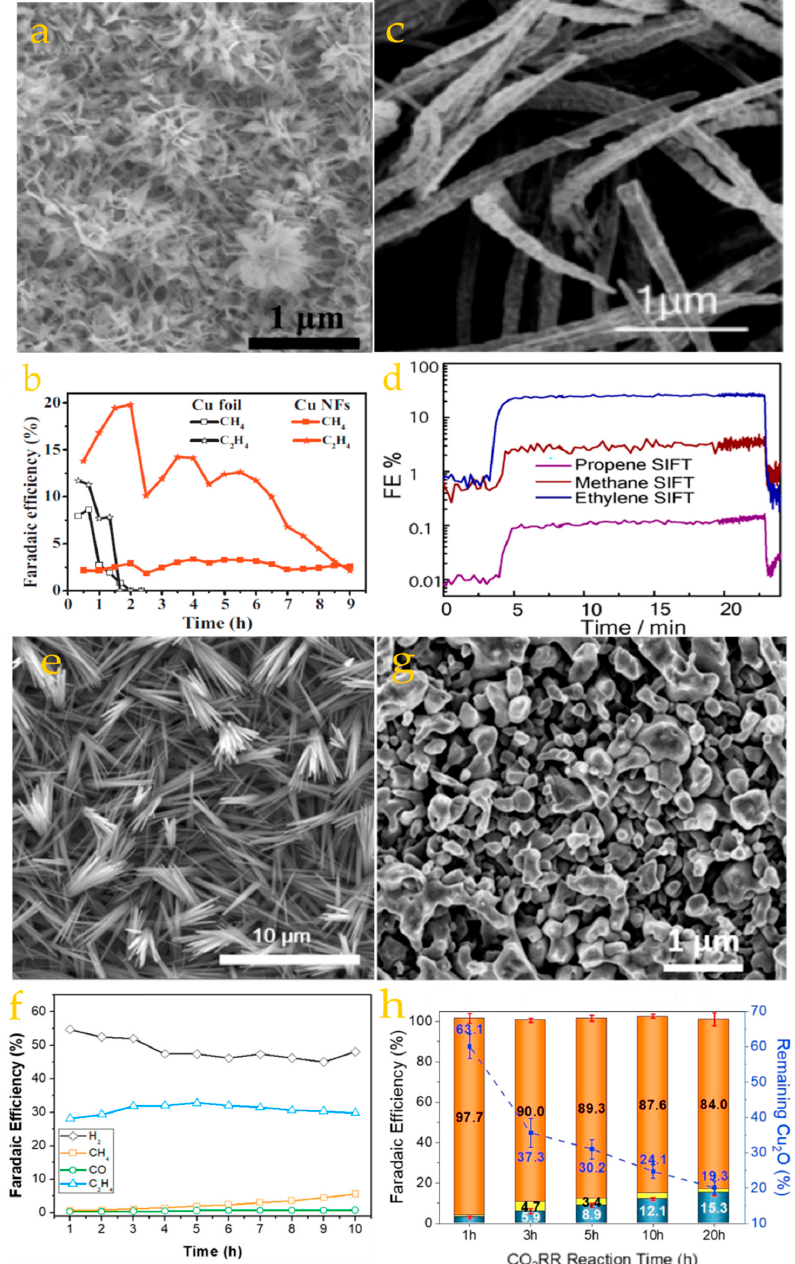
Figure 4. Collective results of morphology analysis (SEM images: ( a , c , e , g )) and CO 2 RR product distribution in time ( b , d , f , h ) for anodically oxidized copper based catalysts: ( a ) SEM image of nanoflower (NF) OD-Cu structure and ( b ) CO 2 RR results for OD-Cu NF and Cu at − 1.3 V vs. RHE in 0.1 M KHCO 3 reproduced from [58] © 2014 Elsevier Ltd.; ( c ) SEM image of nanoneedle (NN) OD-Cu structure and ( d ) constant current CO 2 RR selectivity results of OD-Cu NN in time at − 10 mA cm –2 in 0.1 M KHCO 3 reproduced from [93] © 2018 American Chemical Society; ( e ) SEM image of nanowire (NW) structure OD-Cu and ( f ) CO 2 RR results for OD-Cu NW at − 1.05 V vs. RHE in 0.1 M KHCO 3 reproduced from [106] © 2018 American Chemical Society; ( g ) SEM image of OD-Cu nanoparticles (NP) morphology and ( h ) CO 2 RR results for OD-Cu NP at − 0.64 V vs RHE, under 45 atm. CO 2 in 0.1 M KHCO 3 . Reproduced from [128] © 2020 American Chemical Society.